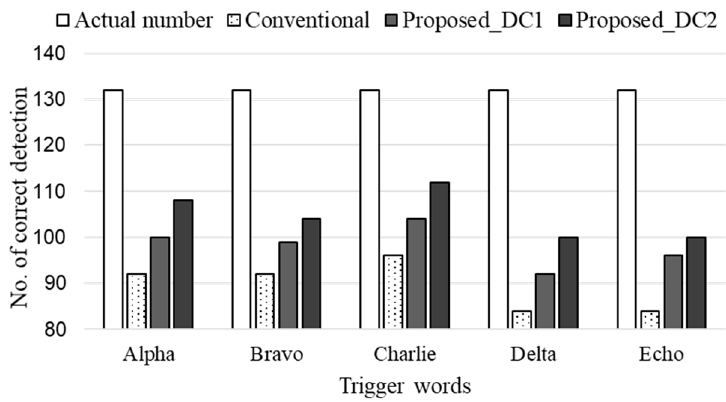
Figure 14. Detection accuracy for respective trigger words.